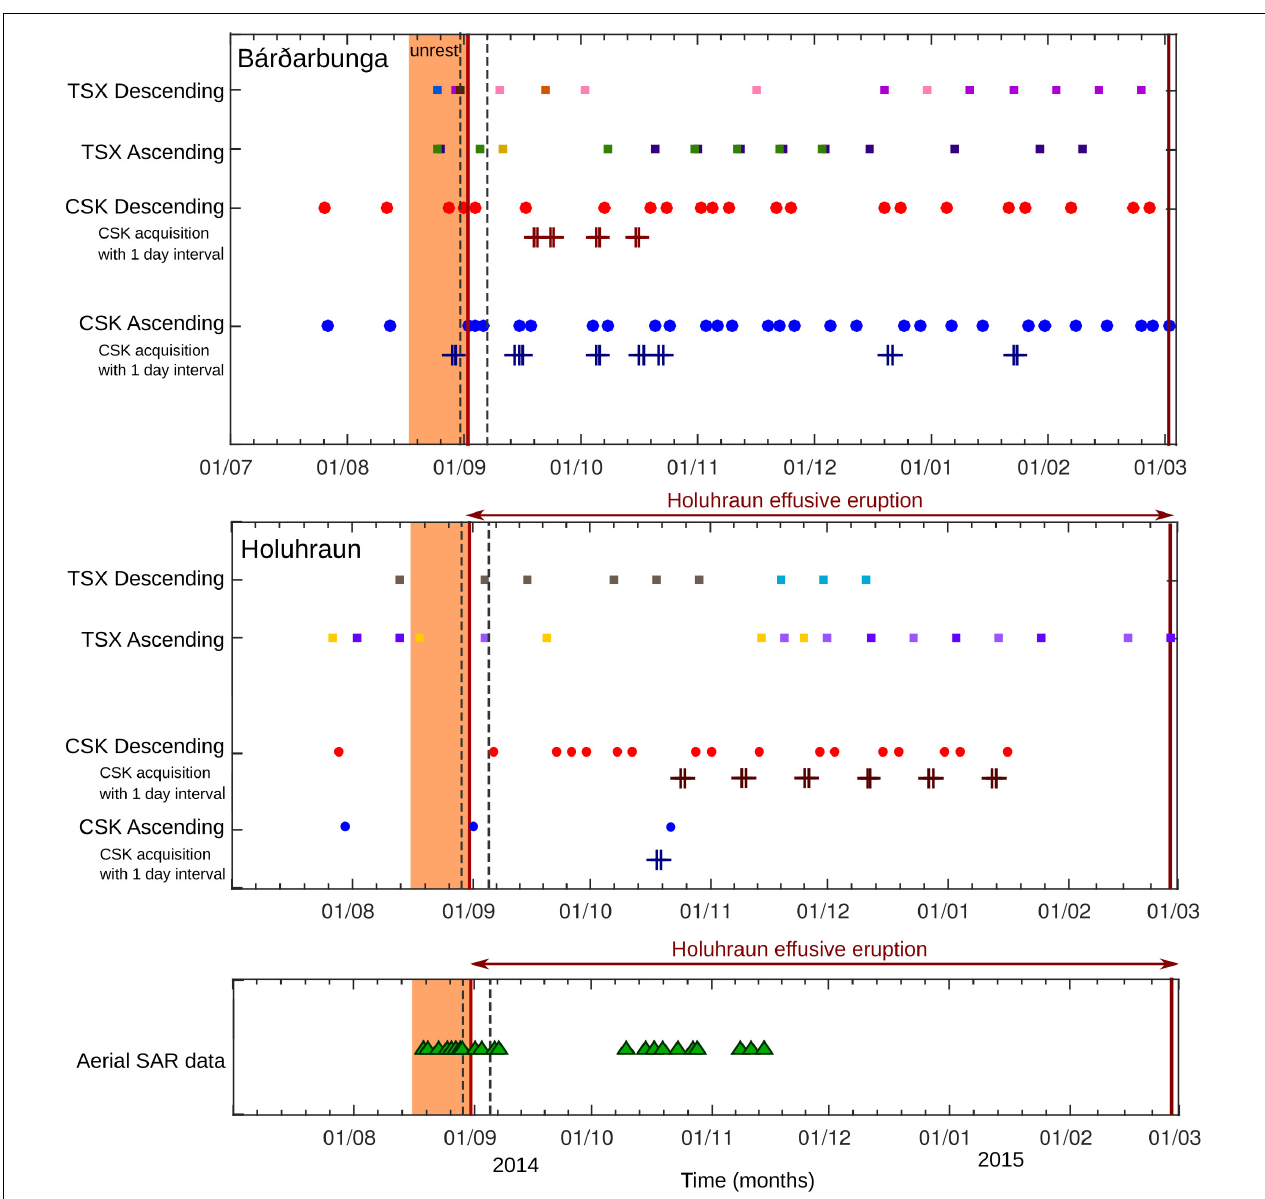
FIGURE 3 | Time-line showing the SAR satellite acquisitions over Bár ð arbunga (upper) and Holuhraun (middle) areas as well as aerial acquisitions (lower) for the unrest period and the 6 months of the eruption. The ascending TSX images over Bár ð arbunga include track 132 (beam 11, green squares), track 56 (beam 7, dark yellow square) and track 147 (beam 3, magenta squares), and the descending ones: track 34 (dark pink for beam 3 and light pink for beam 4), track 125 (light blue), track 49 (brown for beam 1, orange for beam 2). Over the Holuhraun area, TSX ascending configuration includes track 147 (magenta for beam 4 and mauve for beam 5), track 56 (beam 9, yellow) and for the descending TSX images: track 125 (beam 6, blue) and track 140 (beam 14, gray). Aerial SAR images (lower) include Bár ð arbunga caldera and/or Holuhraun area. The red vertical lines mark the onset and the end of the main effusive eruption while the dashed gray lines indicate minor